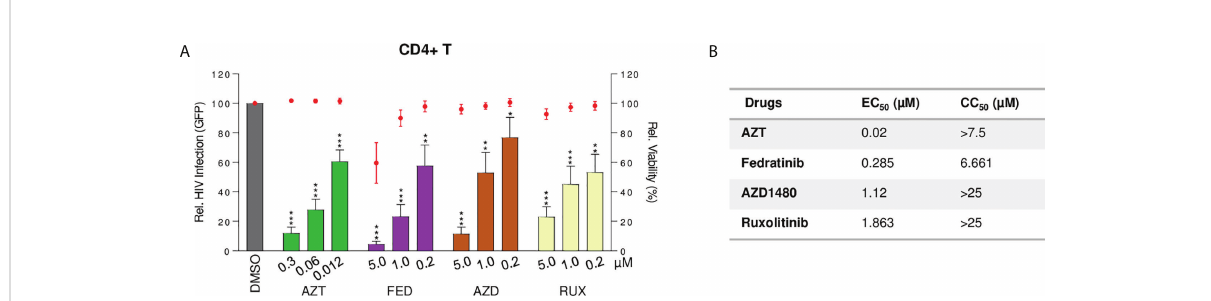
FIGURE 7 Fedratinib is a potent antiviral agent in acute HIV infection, speci fi cally targeting multispliced HIV RNA transcripts. (A) Antiviral activity of JAKi in acute HIV infection of activated CD4+T cells from healthy donors (n = 3). HIV-1 infection was measured as proportion of GFP+ CD4+ T cells after infection with GFP-encoding NL4-3 env-de fi cient HIV-1 clone, 48 h post treatment with compounds at the indicated concentrations. Bar plots represent relative HIV infection and dot plots cell viability of corresponding treatment conditions normalized to the untreated control (DMSO). (B) EC 50 and CC 50 values of JAKi in acute HIV-1 infection model. Values were calculated from (A) . EC 50 , effective concentration required to block HIV-1 replication by 50% and CC 50 , concentration required to induce 50% of cell death in cell culture. (Values are expressed as mean ± SD. **p<0.01;